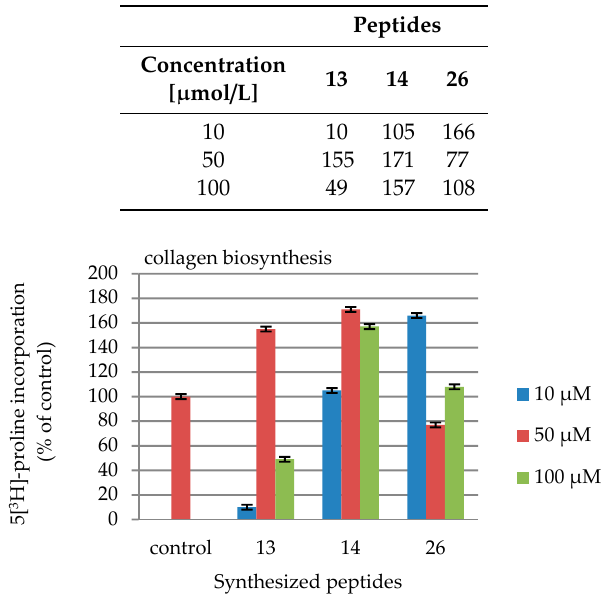
Figure 4. Influence of the synthetized peptides 13 , 14 and 26 on collagen biosynthesis.